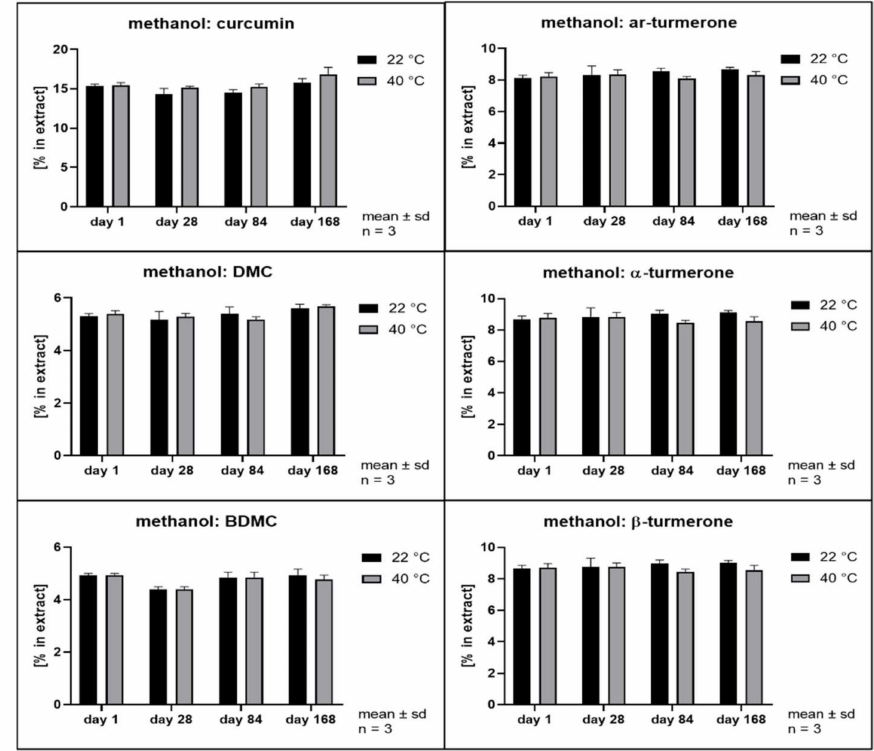
Figure 8. Contents of individual curcuminoids and turmerones in methanolic solvent extracts throughout